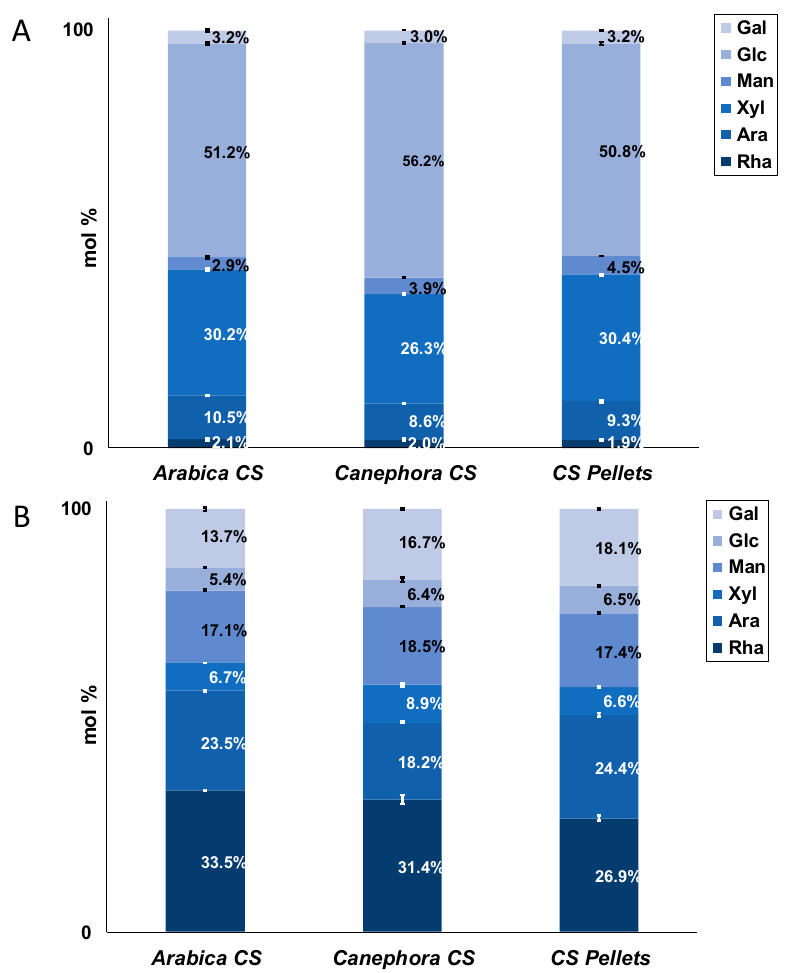
Figure 2. Neutral monosaccharide composition (in mol %) of insoluble dietary fiber ( A ) and soluble dietary fiber ( B ) polysaccharides from coffee silver skin from Coffea arabica ( arabica CS) and Coffea canephora ( canephora CS) as well as coffee silver skin pellets (CS pellets) (Gal, galactose, Glc, glucose; Man, mannose; Xyl, xylose; Ara, arabinose; Rha, rhamnose); n = 2. Table 3. Glycosidic linkage composition of insoluble (IDF) and soluble (SDF) dietary fiber polysaccharides from coffee silver skin from Coffea arabica ( arabica CS) and Coffea canephora ( canephora CS) as well as coffee silver skin pellets (CS pellets). IDF